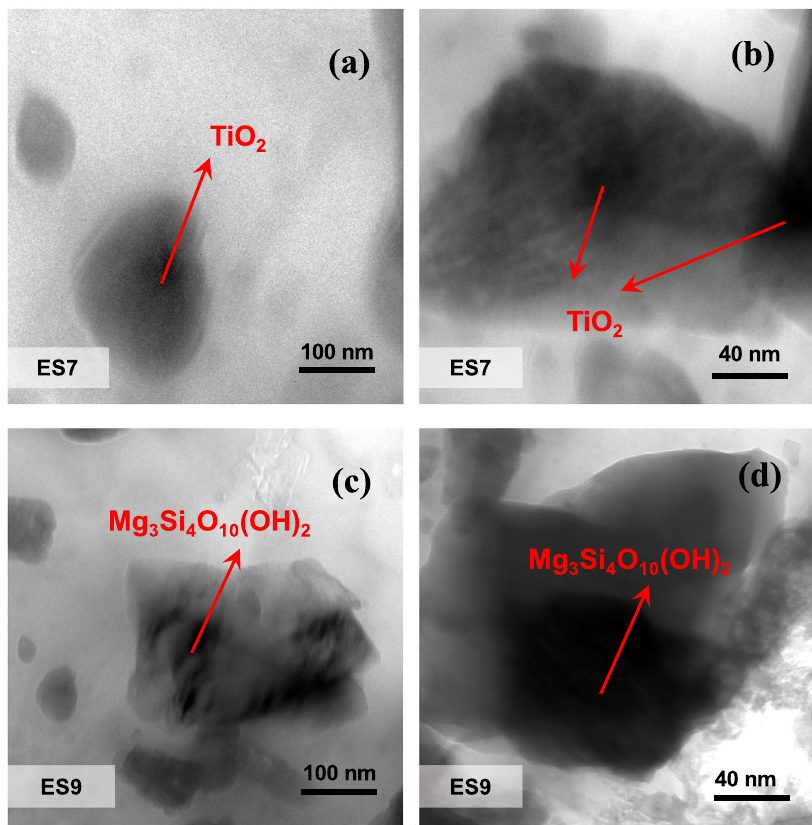
Fig. 2 TEM images of polyurea coatings with a , b ES7 coating sample with TiO 2 + MPP and c , d ES9 sample with Talc +